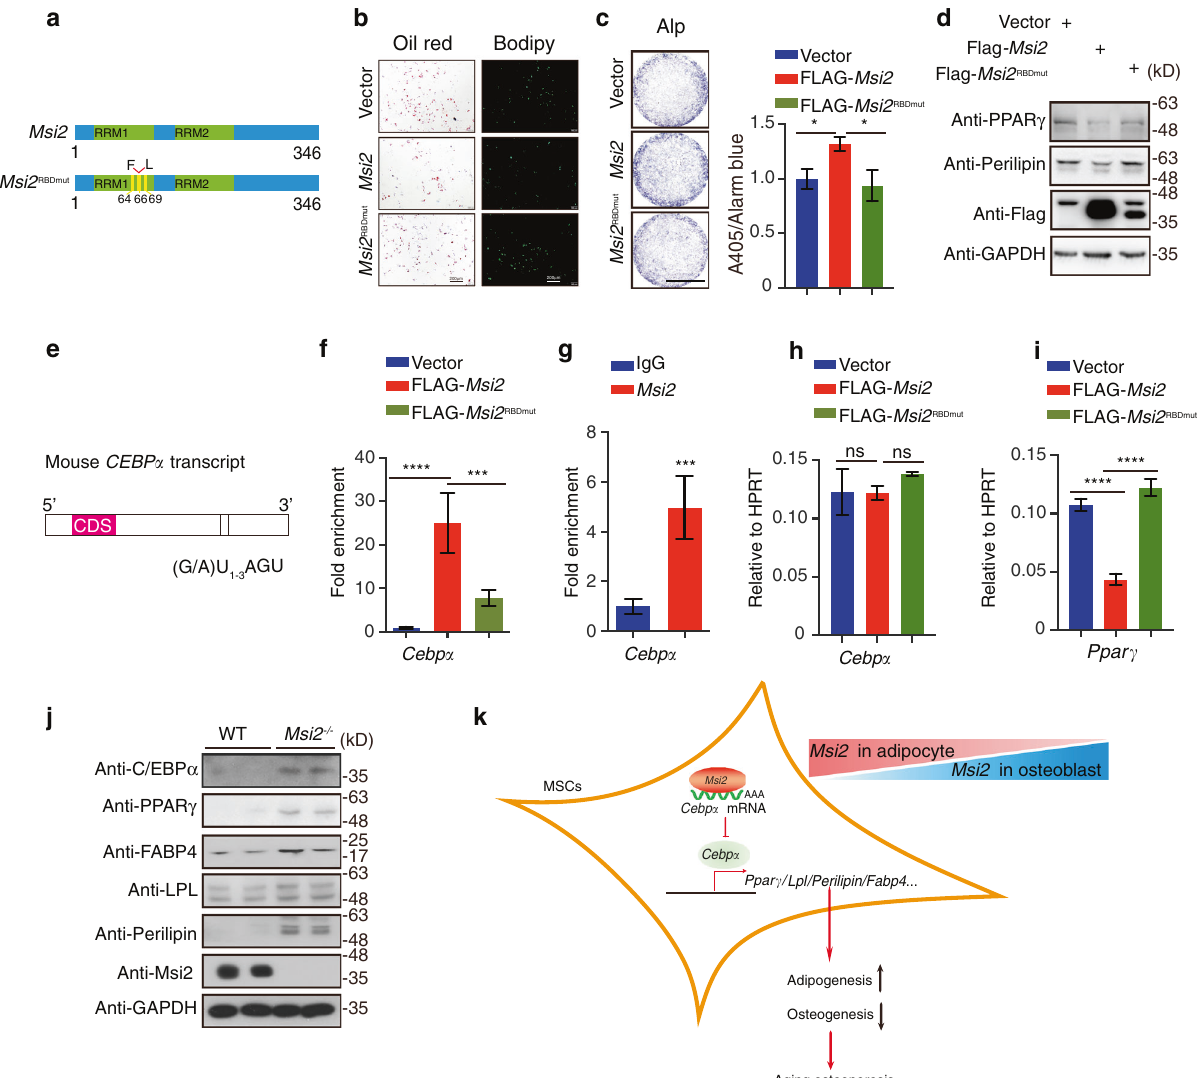
Fig. 6 Msi2 inhibits Cebp α translation and PPAR γ activation in BMSCs. a Schematic illustration of Msi2 and the Msi2 RBDmut mutation. b BMSCs isolated from 4-week-old wild-type mice and treated with Msi2 and Msi2 RBD lentivirus. Cultures were stained with Oil Red O and BODIPY as shown. Scale bar = 200 μ m. c BMSCs isolated from 4-week-old wild-type mice, and treated with Msi2 and Msi2 RBD lentivirus. Cultures were stained with ALP, and ALP activity was quanti fi ed as shown. Scale bar = 3 mm. Data represent the mean ± SD, * P < 0.05, one-way ANOVA. d Western blot analysis of PPAR γ and perilipin protein levels in the C3H10 cells overexpressing Flag-tagged Msi2 and Msi2 RBDmut protein; GAPDH was used as a reference protein. e Schematic of the mouse Cebp α transcript. Bars, the putative MBEs (r(G/A)U 1 – 3 AGU). Two MBEs were identi fi ed within the 3 ′ UTR of Cebp α . CDS, coding sequence for mC/EBP α protein. f RIP with anti-Flag antibody from C3H10 cells expressing empty vector, Flag-tagged Msi2 or Flag – Msi2 RBDmut . Coimmunoprecipitated RNAs were analyzed for the enrichment of Cebp α transcripts. n = 3 each. Data represent the mean ± SD, *** P < 0.001, **** P < 0.000 1, one-way ANOVA. g RIP with anti- Msi2 antibody or a control rabbit IgG from BMSCs. Coimmunoprecipitated RNAs were analyzed for the enrichment of Cebp α transcripts. n = 3 each. Data represent the mean ± SD, *** P < 0.001, ordinary one-way ANOVA. h qPCR results of Cebp α in the C3H10 cells overexpressing Flag-tagged Msi2 and Msi2 RBDmut proteins. Data represent the mean ± SD, ns: no signi fi cance, one-way ANOVA. i qPCR results of Ppar γ in the C3H10 cells overexpressing Flag-tagged Msi2 and PPAR